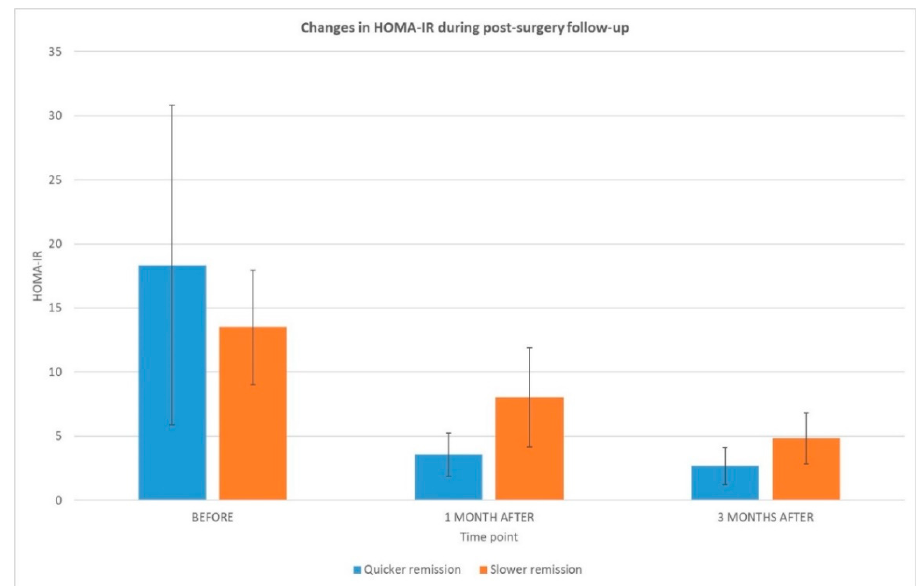
Figure 1. Changes in HOMA-IR (with its standard deviation) during follow-up after the bariatric surgical procedure in the groups with quicker ( blue ) and slower ( orange ) diabetes remission.